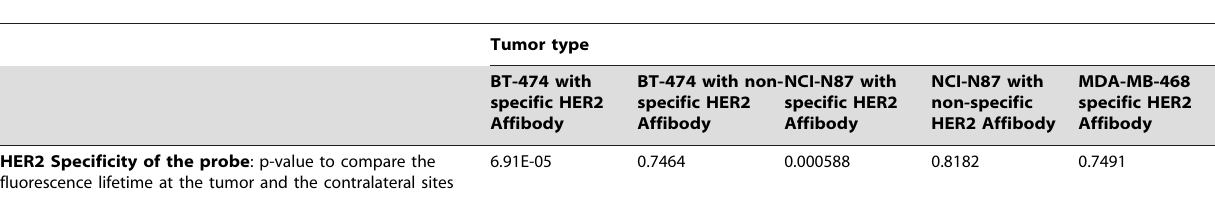
Table 1. Statistical significance of the measurements between 30 min to 5 hours at the tumor and contralateral site after injection, using Wilcox Two-Sample